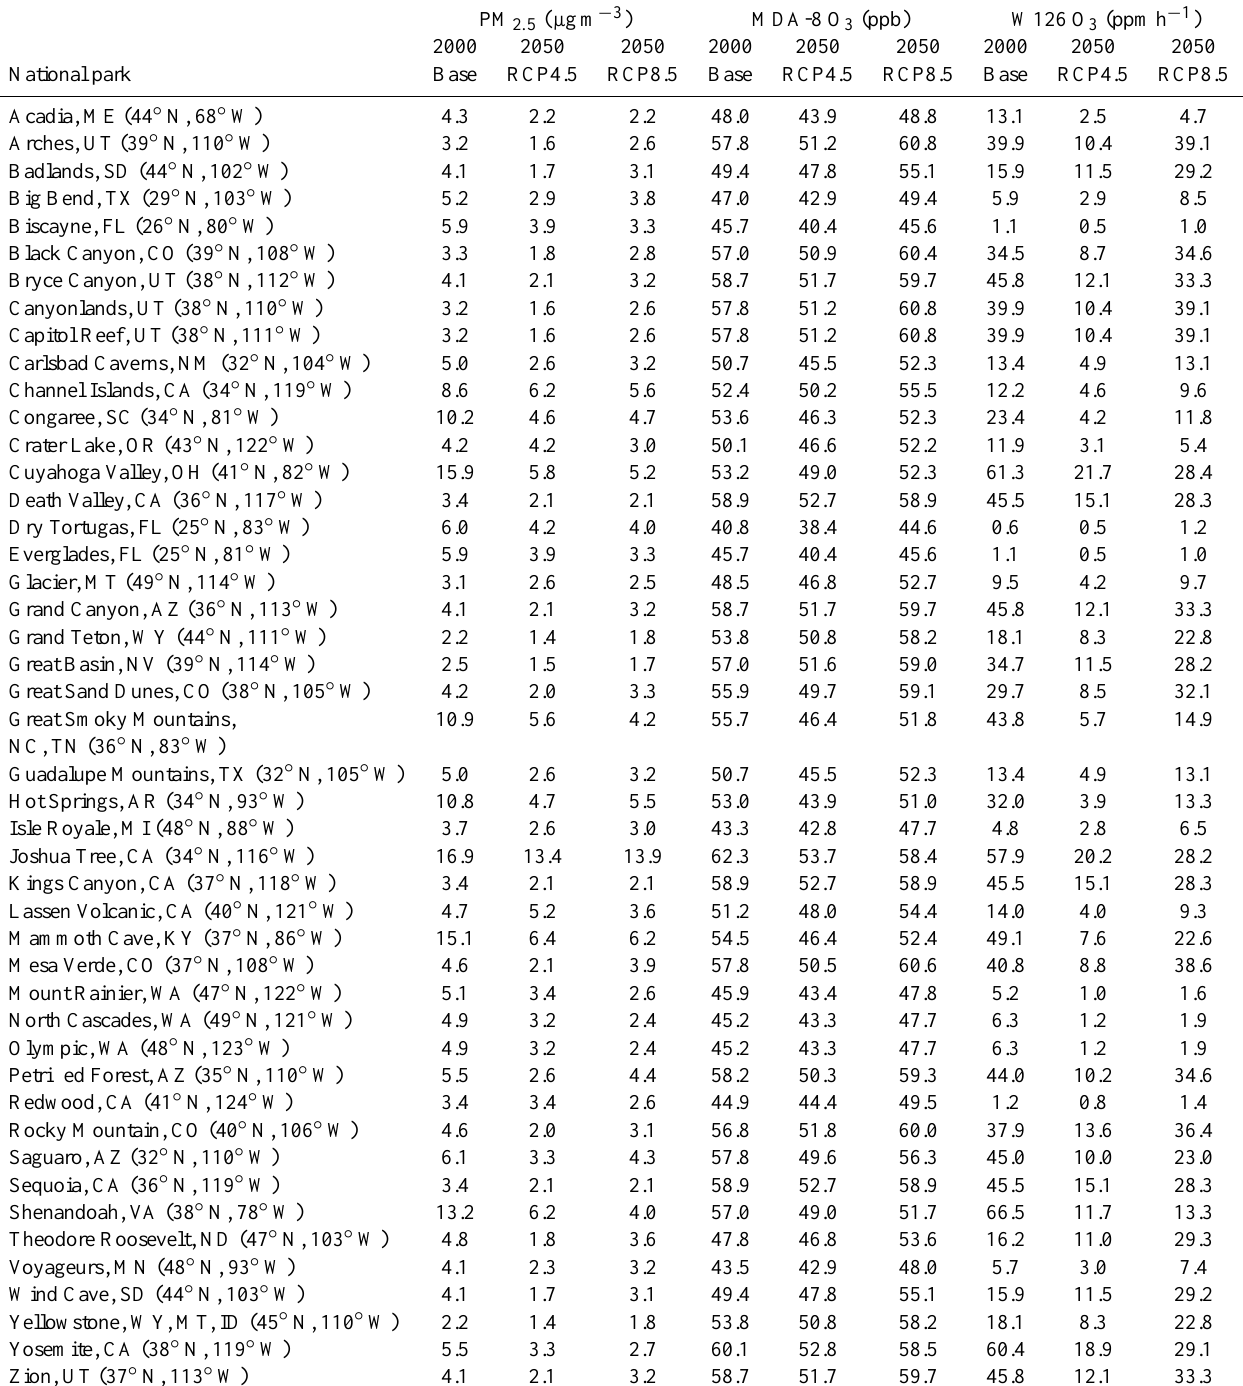
Table 4. Simulated annual air quality over the US national parks and wilderness areas a